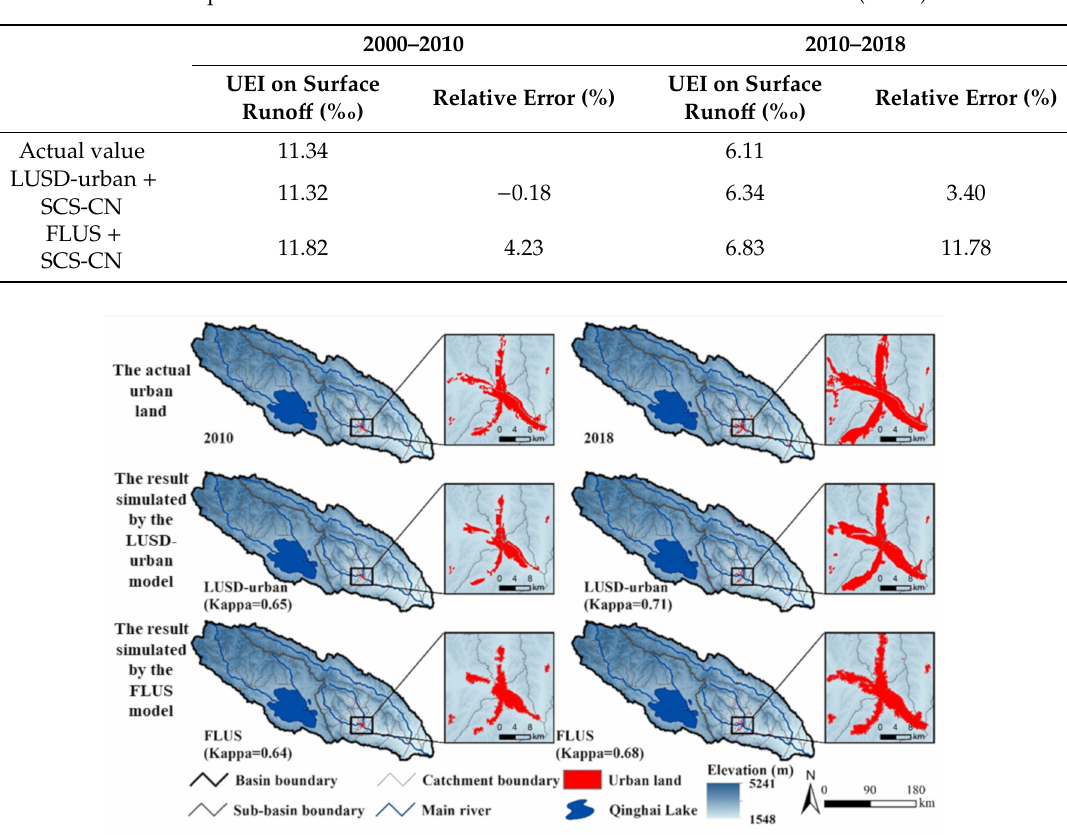
Figure 12. The comparison between the LUSD-urban and FLUS